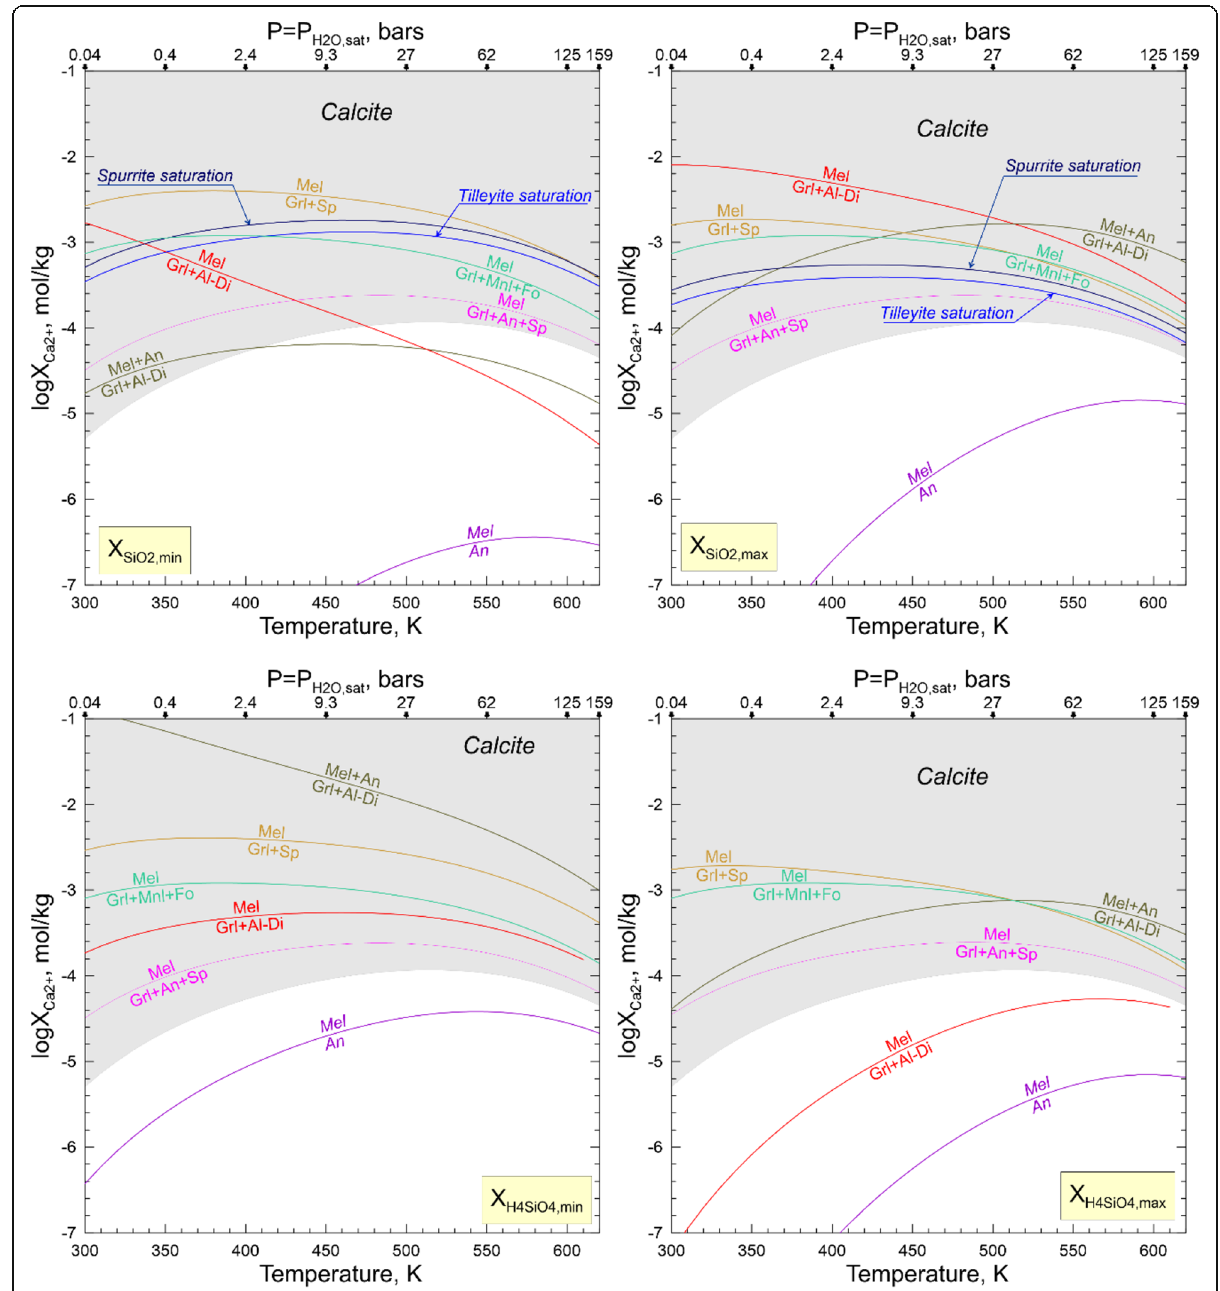
Fig. 18 Phase boundaries of reactions involving addition of either aqueous SiO 2 or gaseous H 4 SiO 4 and removal of Ca in the form of dissolved Ca bicarbonate, Ca 2+ + 2HCO 3 − , at X CO2 defined by R28 (wollastonite-calcite-tilleyite equilibrium) and different values of SiO 2 activity and H 4 SiO 4 fugacity defined by reactions R5 and R11 (Fig. 19). In each plot, the labeled curves of different colors separate the “ primary ” (above the curves) and “ secondary ” (below the curves) assemblages which correspond to the reactants and products of each reaction, respectively. The gray calcite saturation line separates two different phase assemblages containing silicates + calcite + aqueous solution above the line and silicates + aqueous solution below it. The tilleyite and spurrite saturation curves show conditions when a mineral starts to crystallize from an aqueous solution according to a reaction Ca 2+ + HCO 3 − + SiO 2 → xCaO ∙ ySiO 2 ∙ zCO 2 + CO 2(g) + H 2 O